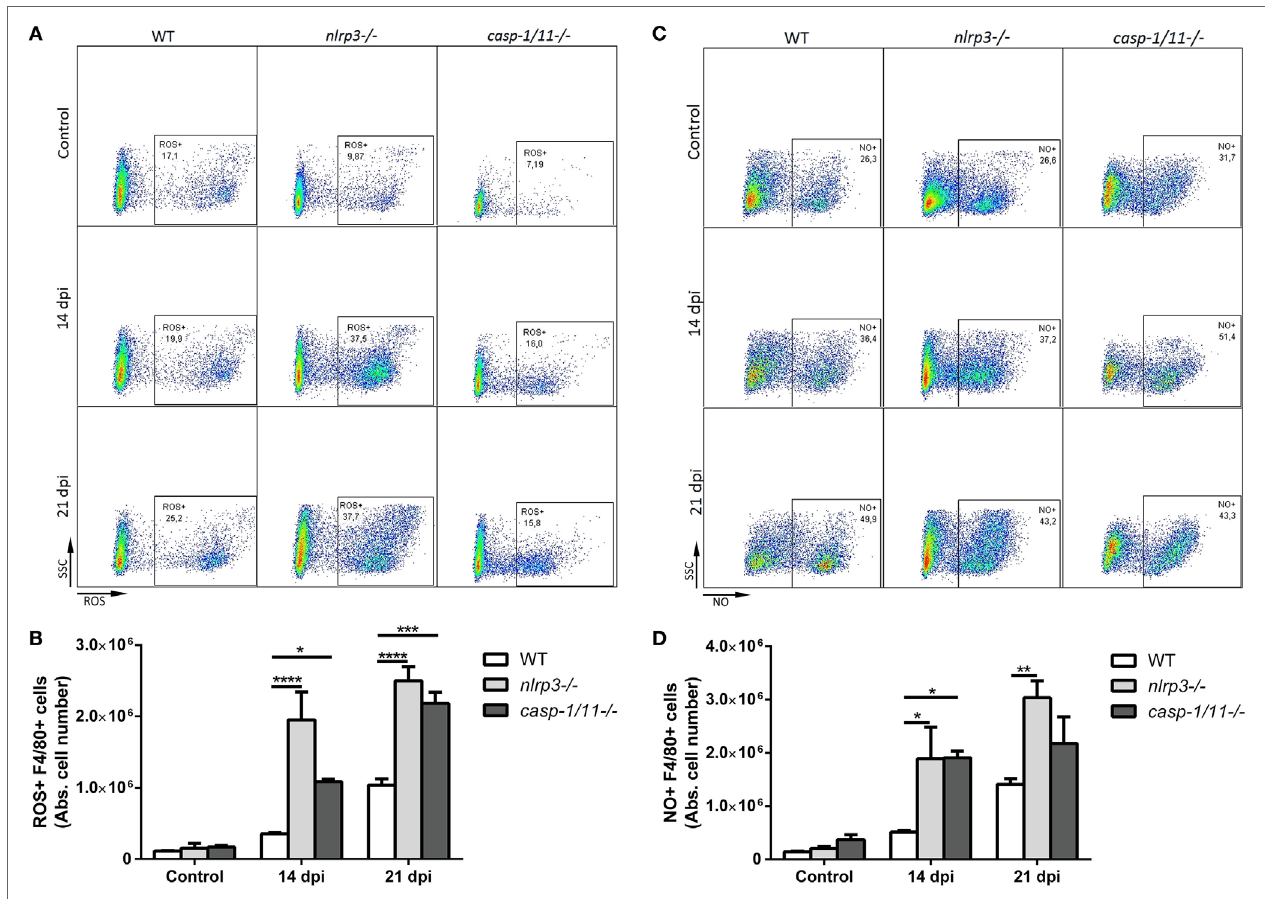
FigUre 3 | Hepatic macrophages from NLRP3- and caspase-1/11-deficient mice exhibit increased intracellular production of reactive oxygen species (ROS) and nitric oxide. Intrahepatic leukocytes from infected and uninfected controls from wild type (WT), nlrp3 − / − , and caspase-1/11 − / − mice were stimulated with PMA and ionomycin. ROS were detected within cells by labeling with the oxidation-sensitive dye H2DCFDA and NO was measured using DAF-FM as described in Section “Materials and Methods.” Then, cells were stained with anti-F4/80. (a) Representative dot plots and (B) absolute number of ROS + F4/80 + intrahepatic cells from WT, nlrp3 − / − , and caspase-1/11 − / − mice. (c) Representative dot plots and (D) absolute number of hepatic NO + F4/80 + cells from WT, nlrp3 − / − , and caspase-1/11 − / − mice measured by flow cytometry. Gate strategy is depicted in Figure S1 in Supplementary Material. Data are shown as mean ± SEM from one of three representative experiments; n = 3–6 mice per group. Statistical significance was evaluated by two-way ANOVA followed by Bonferroni post hoc test. * p < 0.05; ** p < 0.01; *** p <